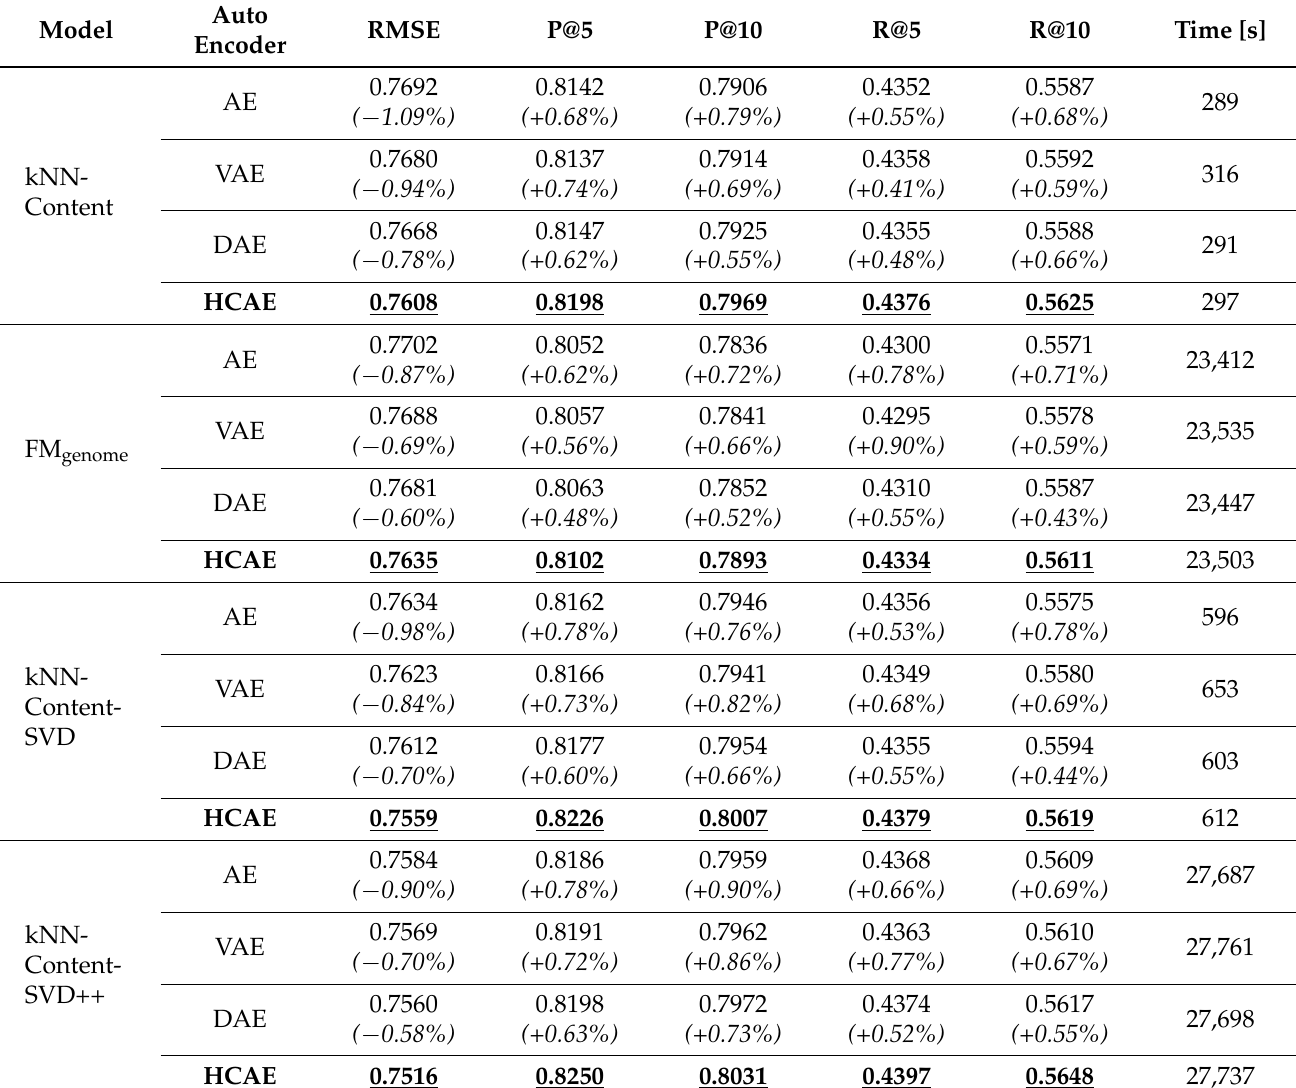
Table 4. Performance comparison of the baseline models when utilizing 600-element movie feature vectors generated from AE variants and an